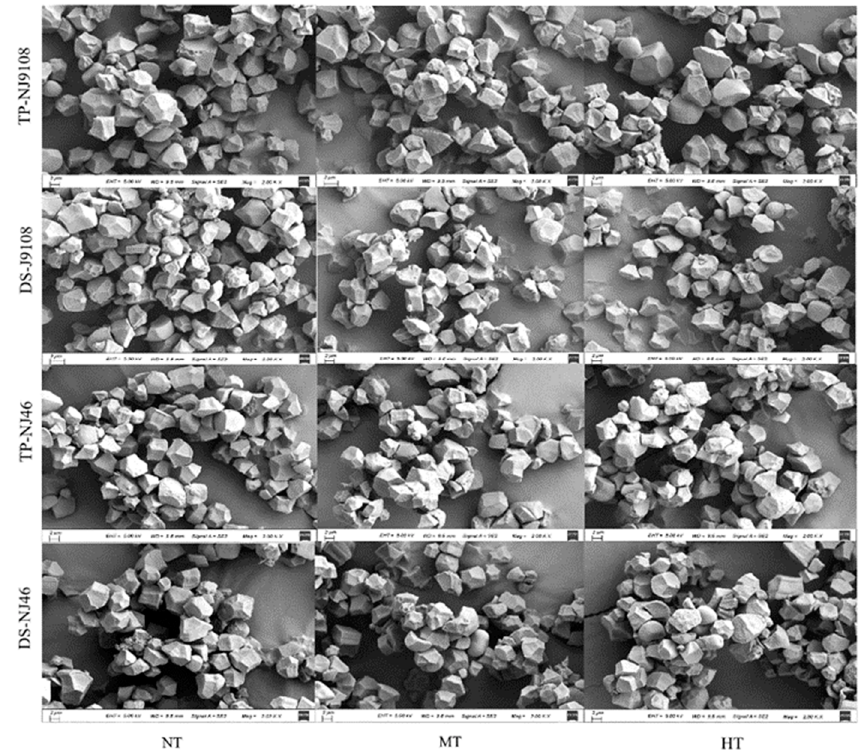
Figure 2. Effects of high temperature on starch morphological structure of japonica rice in middle heading stage under transplanting and direct seeding (2000×).